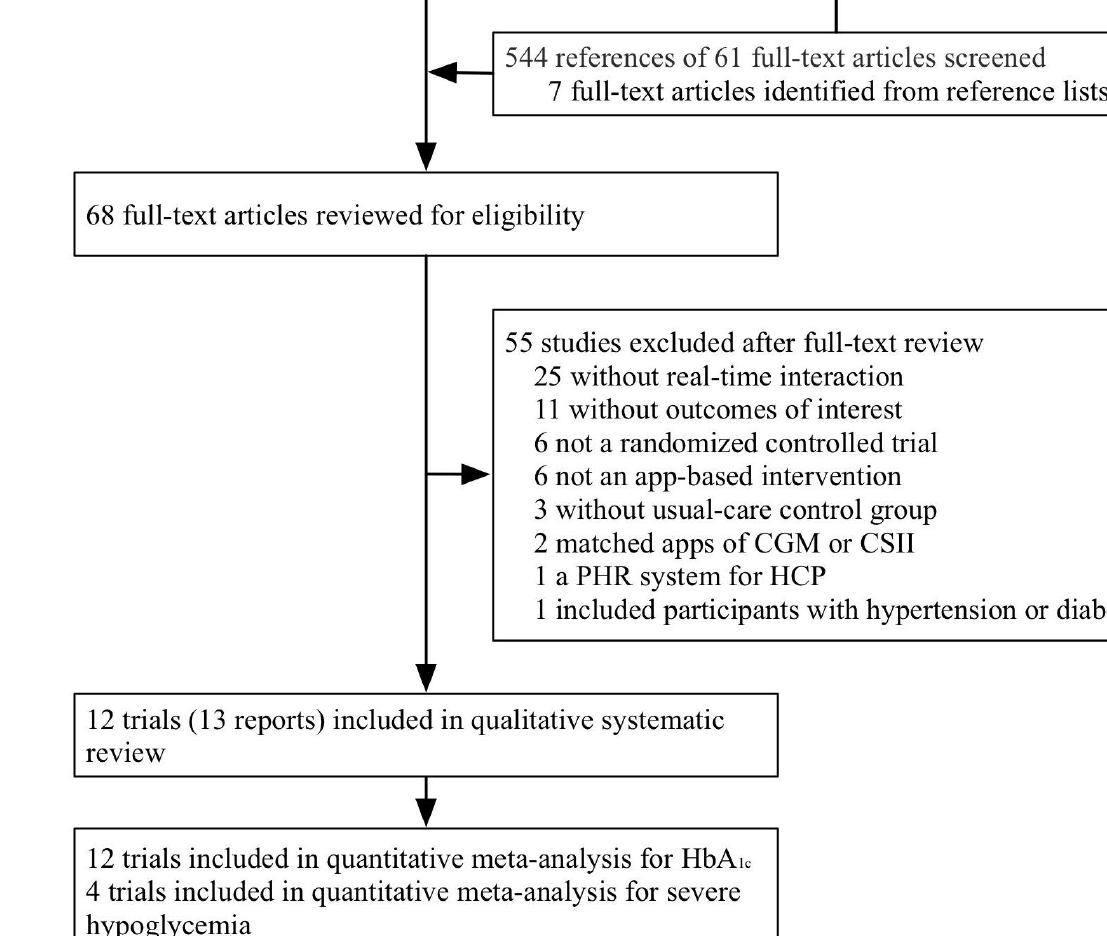
concealing the allocation sequence. As an objective outcome, all trials adequately blinded the assessment of the primary outcome (HbA changes). The corresponding proportion for 1c incomplete outcome data was 25% (3/12), for selective